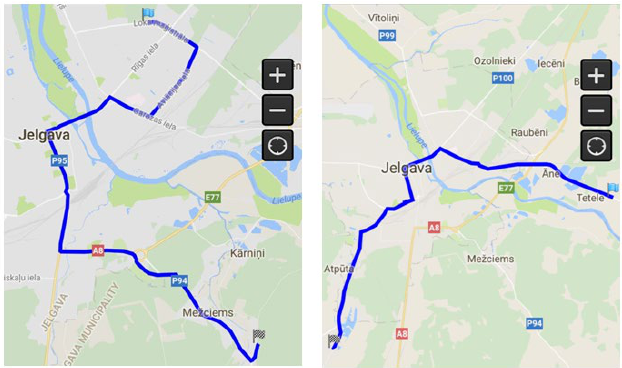
Fig. 3. Routes 5 and 2 in the map. Figures from SpeedTracker